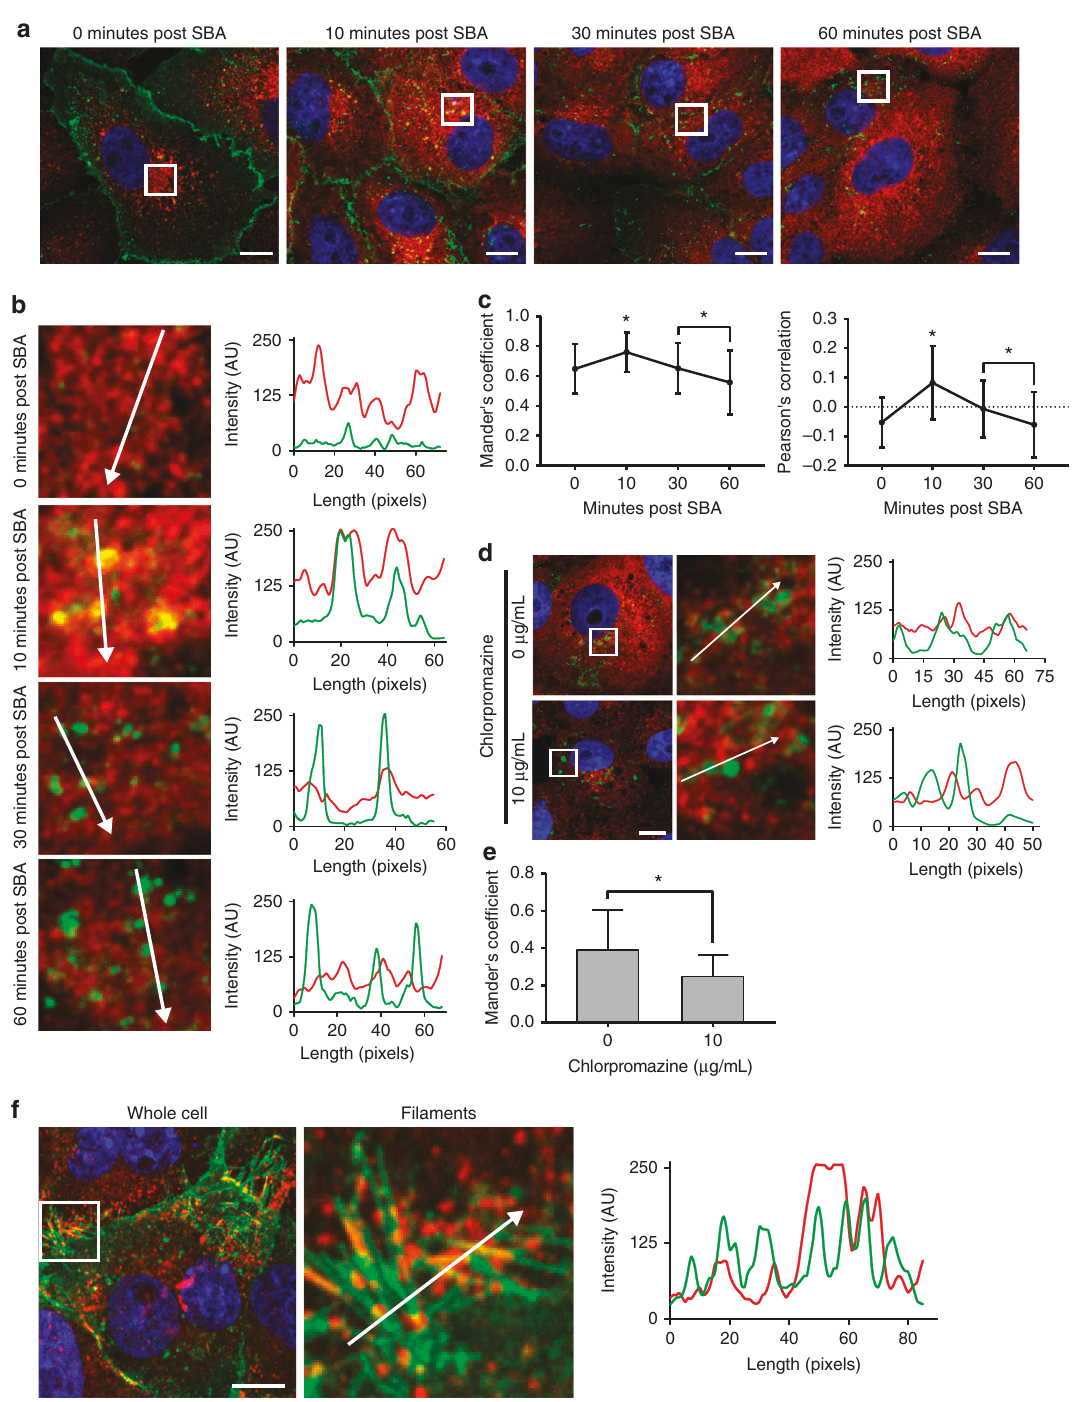
Fig. 5 RSV G protein internalizes via clathrin and colocalizes with caveolin in viral fi laments. a RSV infected Vero cells were stained for RSV G with SBA-488 ( green ). The cells were incubated at 37 °C before being fi xed and stained for CHC at the indicated time points ( red ). The cell nuclei were stained with DAPI ( blue ). Scale bar represents 10 µ m. b Enlargements of cropped images from the white boxed regions in part a with intensity pro fi les showing colocalization along the direction of the white arrow . c Mander ’ s colocalization coef fi cient and Pearson ’ s correlation between RSV G and CHC. Dotted line indicates 0 correlation. Error bars represent standard deviation. Asterisk indicates p < 0.05 (Mann – Whitney U test). n = 30 cells per group. d Infected Vero cells at 12 hpi were treated with the indicated concentration of chlorpromazine in media for 2 h. RSV G was labeled with SBA-488 at 4 °C followed by a 1 h incubation at 37 °C in media with drug. Cells were fi xed and stained for CHC. Scale bar represents 10 µ m. Enlargements of cropped images from the white boxed regions with intensity pro fi les showing colocalization along the direction of the white arrow. e Mander ’ s colocalization coef fi cient between RSV G and CHC. Error bars represent standard deviation. Asterisk indicates p < 0.05 (Mann – Whitney U test). n = 30 cells per group. f Vero cells were infected with RSV A2 at on MOI of 1. At 24 hpi, RSV G was labeled with SBA-488 ( green ) and cells were fi xed and stained for caveolin ( red ) and nuclei ( blue ). Enlargement of cropped image from the white boxed region with an intensity pro fi le showing colocalization along the direction of the white arrow . Scale bar represents 10 µ